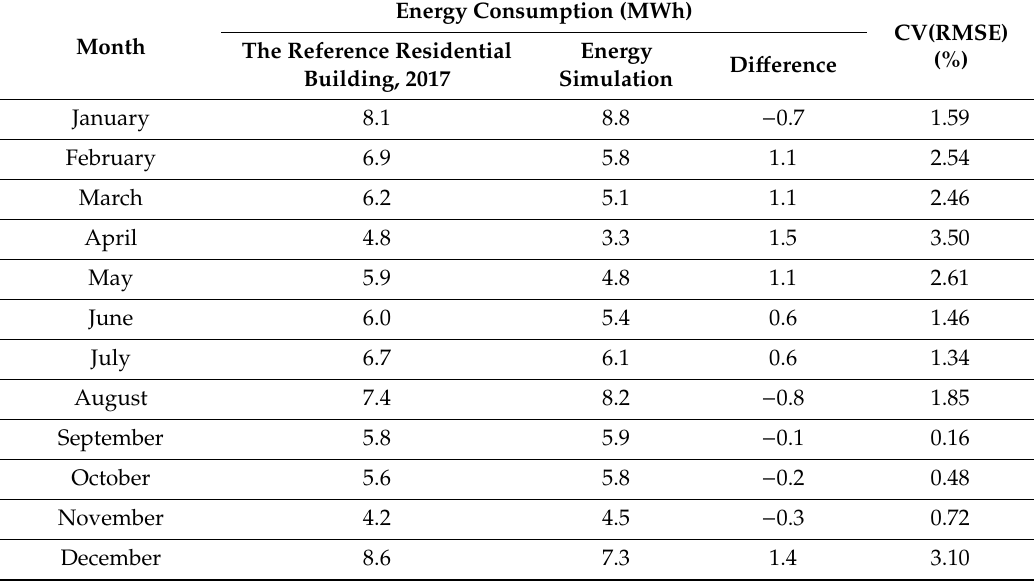
Figure 8. Energy consumption comparison between the reference residential building and the energy simulation. Table 4. The monthly energy consumption comparison for the reference case.